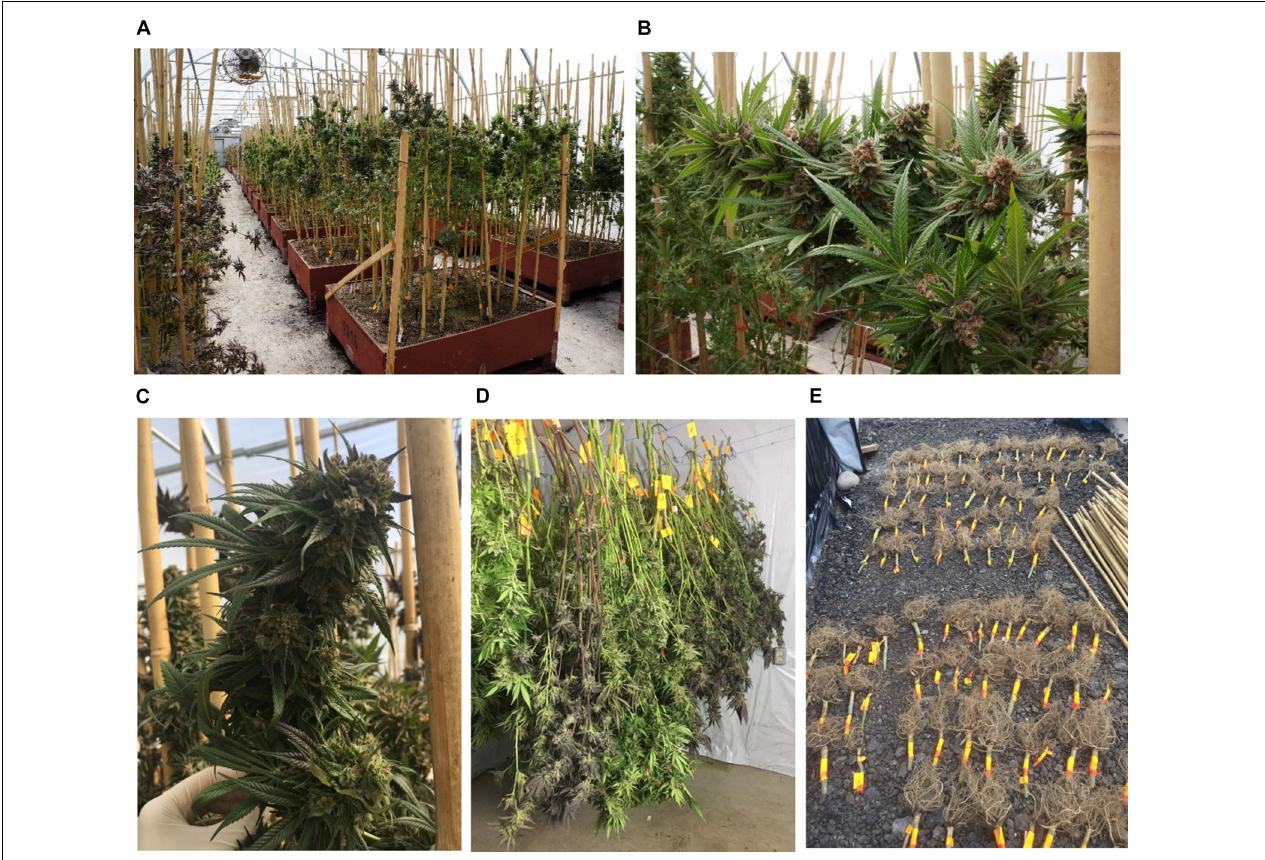
FIGURE 1 | Cannabis grown in a commercial greenhouse. (A–C) Cannabis plants before harvest. (D) Whole cannabis plants were cut above the ground and hang to dry in a drying room. (E) Cannabis roots were individually labeled and dried in the drying room with the other plant